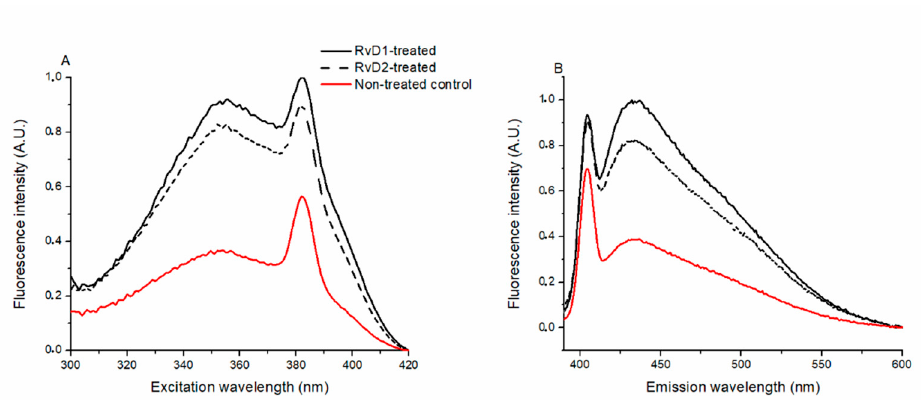
Figure 7. Effect of RvD1 and RvD2 on Laurdan excitation ( A ) and emission ( B ) spectra on CHO cells. Excitation wavelength: 440 nm, emission wavelength: 355 nm. Solid (black) or dashed and solid (red) curves represent the RvD1 or RvD2 and non-treated control samples, respectively.